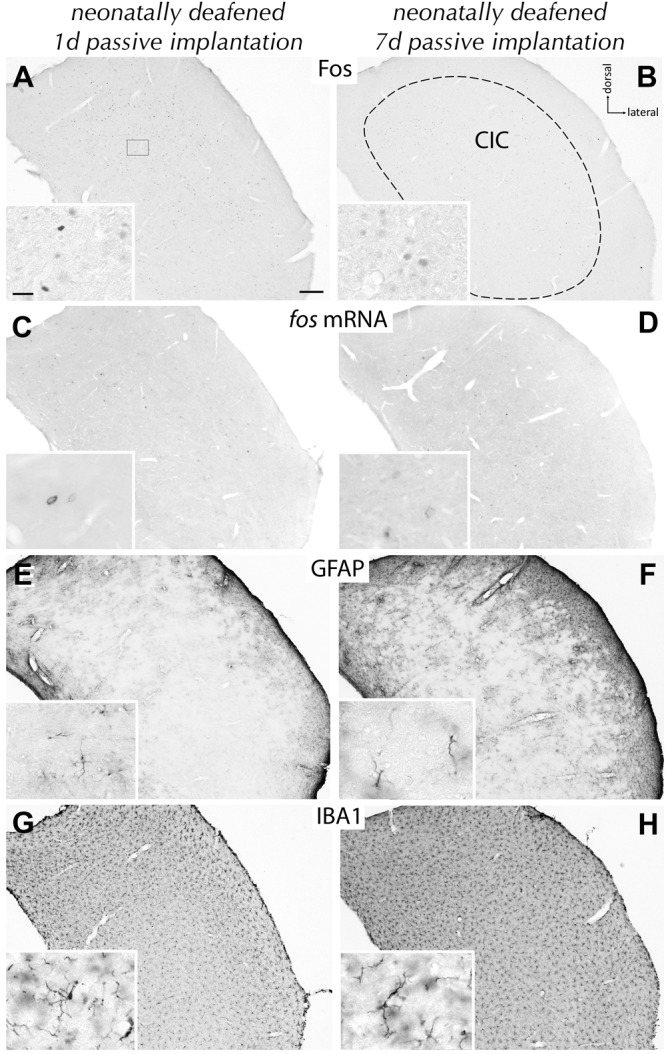
Absence of effects after passive intracochlear electrode implantation for 1 or 7 d. Staining of Fos protein (A,B), fos mRNA (C,D), GFAP (E,F), or IBA1 (G,H) in the CIC contralateral to the intervention. After implantation of a passive electrode, intensity and pattern of staining for the markers used remained unchanged and indistinguishable from the ipsilateral (i) CIC or the CIC of untreated rats. Frame in (A) indicates approximate intracollicular position for all insets. Scale bar for major panels: 200 μm; scale bar for insets: 20 μm.